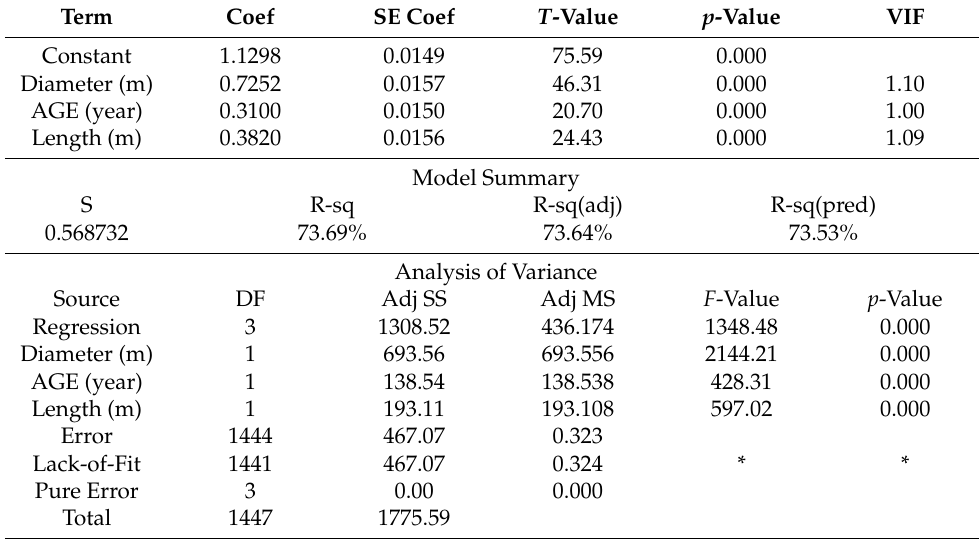
Table 5. Regression Analysis of Concrete Stormwater